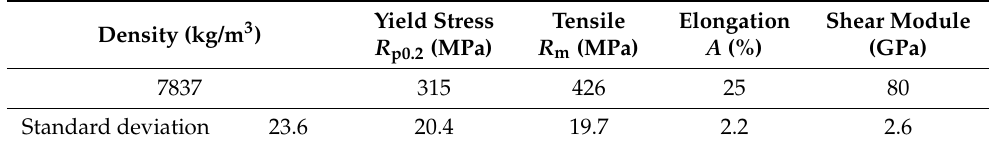
Table 3. Mechanical properties of S235JR + AR steel.